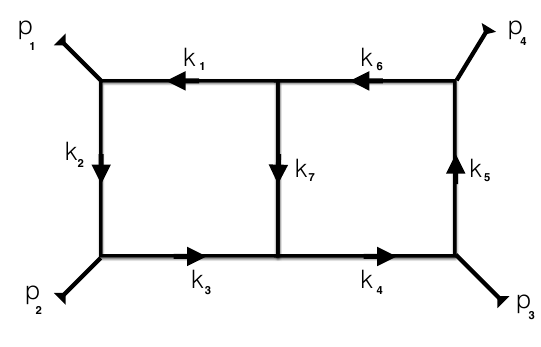
Figure 7 . The two-loop